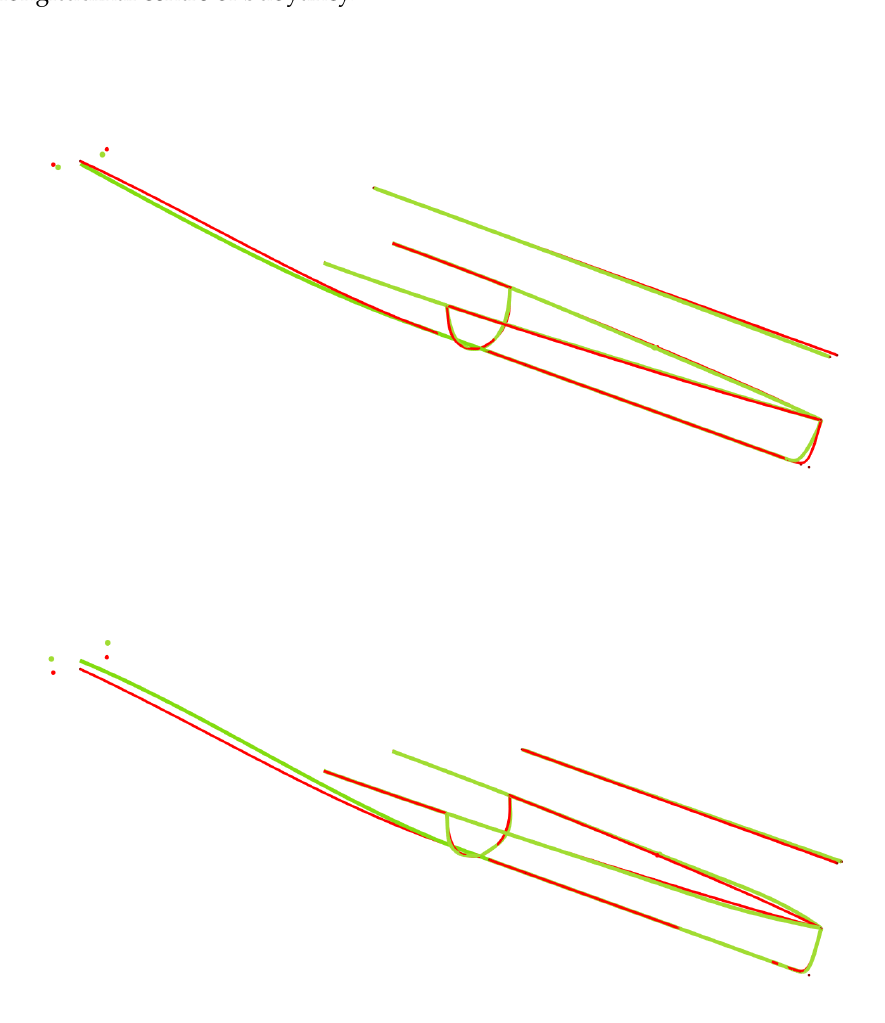
Figure 8. Matching source (red) and target (green) curves corresponding to minimum and maximum values of free variables in CAD